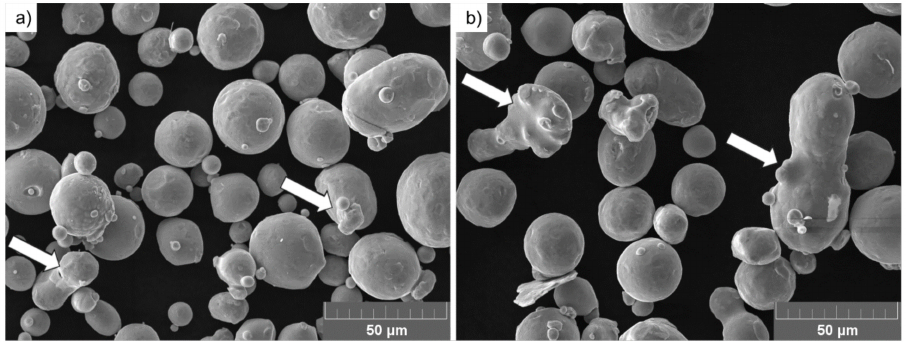
Figure 2. SEM micrographs of the Ti6Al4V powders: ( a ) FRESH powder showing particles with satellites (marked with arrows) and ( b ) USED powder showing the appearance of irregular particles (marked with arrows).